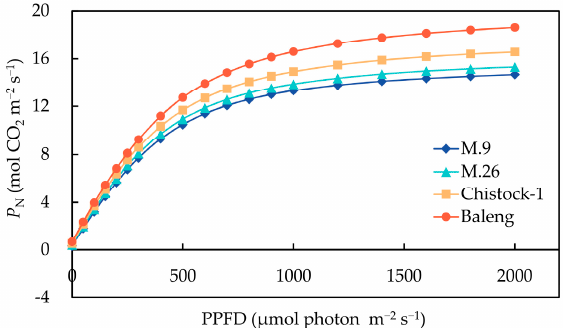
Figure 7. ‘Red Fuji’ scion leaf light-response curves influenced by rootstocks. Parameters were measured on the same functional leaves. Different symbols indicate the leaf net photosynthetic rate ( P N ) of different grafted apple combinations ( n = 3), measured under photosynthetic photon flux density (PPFD) gradients. Table 3. Parameters of photosynthetic light response curves on grafted apple combination, including light-saturated net photosynthetic rate ( P Nmax ), dark respiration rate ( R D ), light compensation point (LCP), light saturation point (LSP), and apparent quantum yield ( φ ).